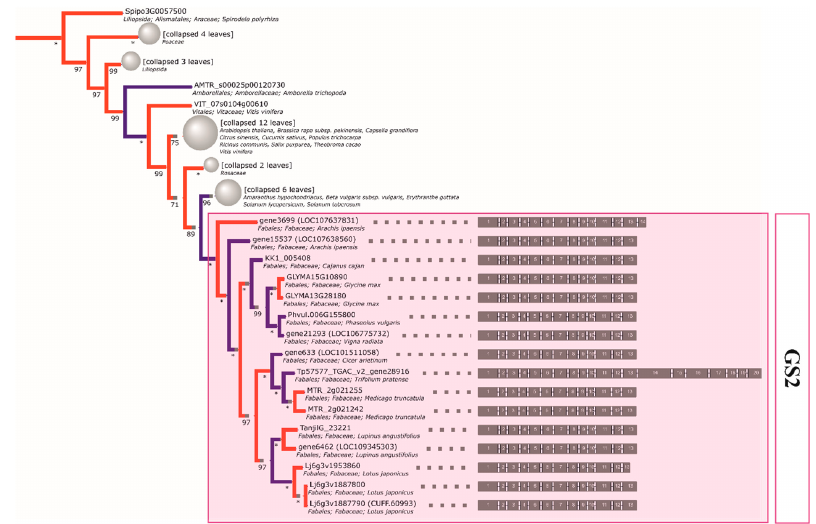
Figure 1. The reconstructed phylogeny of plant plastid GS isoenzyme ( GS2 ) genes. A collapsed phylogeny tree was used in order to highlight Fabaceae family relationships.